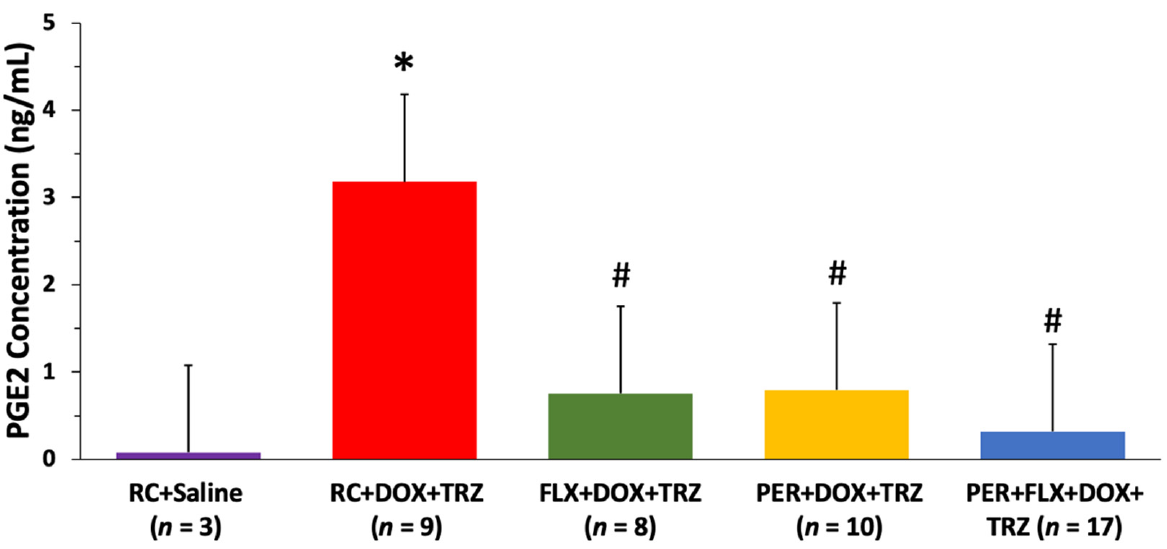
Figure 5. Changes in PGE2 concentrations in mice prophylactically administered FLX, PER, or FLX + PER treated with DOX + TRZ. C57Bl/6 female mice treated with RC + DOX + TRZ demonstrated a significant increase in the inflammatory oxylipin PGE2 at week 6. Prophylactic treatment with FLX, PER, or FLX + PER significantly attenuated elevations in PGE2 associated with DOX + TRZ administration. Data are expressed as mean ± SD. * p < 0.05 RC + DOX + TRZ vs. RC + saline. # p < 0.05 FLX + DOX + TRZ or PER + DOX + TRZ or PER + FLX + DOX + TRZ vs. RC + DOX + TRZ. DOX, doxorubicin; FLX, flaxseed; PER perindopril; PGE2, prostaglandin E2; RC, regular chow; SD, standard deviation; TRZ, trastuzumab.